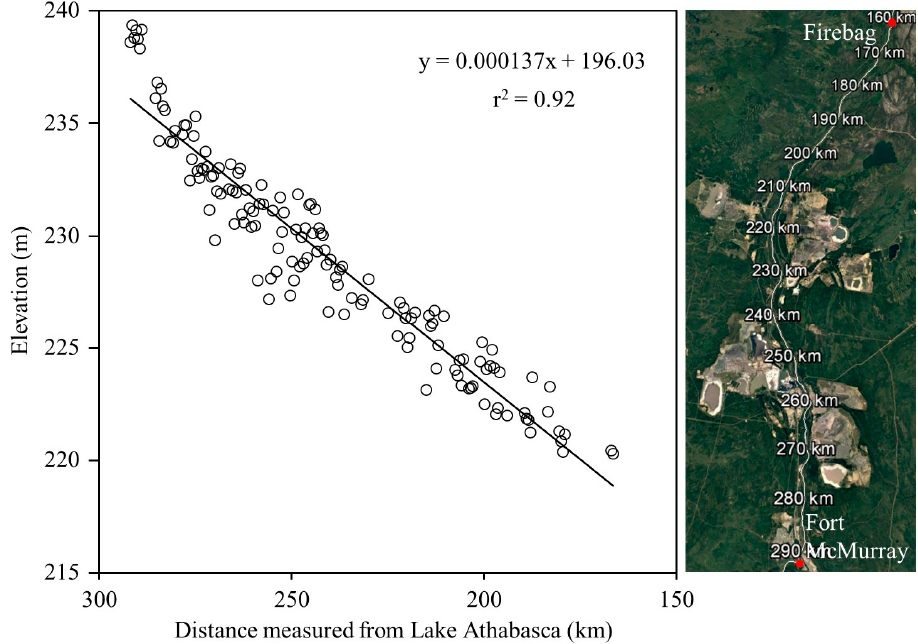
Figure 4. The longitudinal bed profile of the Athabasca River from Fort McMurray to the Firebag River confluence (elevation data were extracted along the center line of the river at 500 m interval).